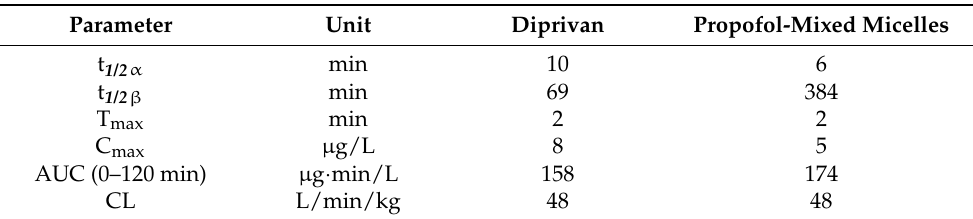
Table 6. Pharmacokinetic parameters of propofol following intravenous injection of propofol-mixed micelles and Diprivan to